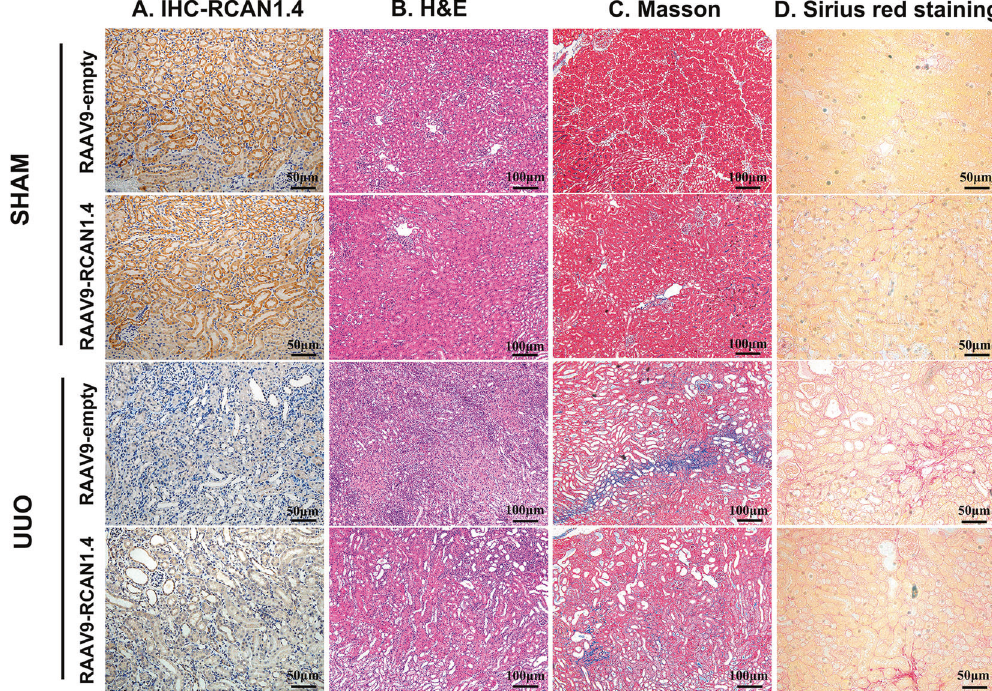
Fig. 2 Forced RCAN1.4 overexpression by rAAV9-packed RCAN1.4 over-expression plasm alleviated UUO-induced renal fi brosis. A – D Representative RCAN1 (Scale bars, 50 μ m), H&E (Scale bars, 100 μ m), Masson (Scale bars, 100 μ m), Sirius red (Scale bars, 50 μ m) of kidney interstitium